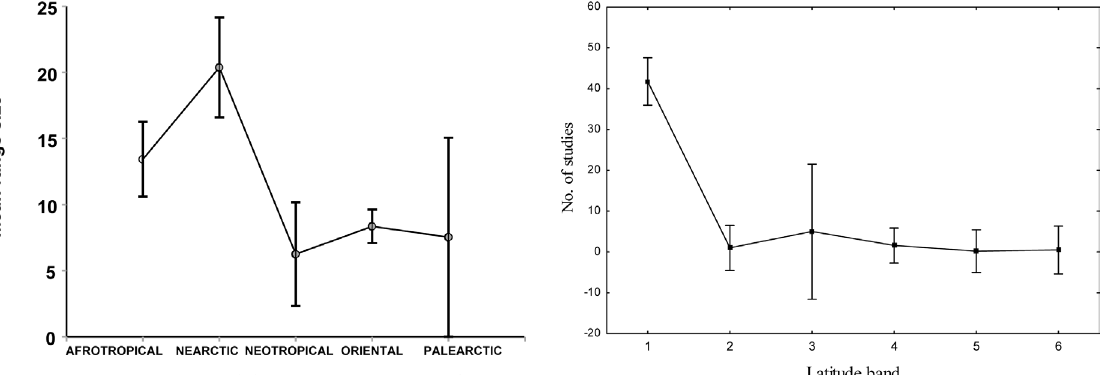
Figure 3. Mean range size (and dispersion measure, SD) for Sciu- ridae genera in the various biogeographic regions. For statistical details, see the text.